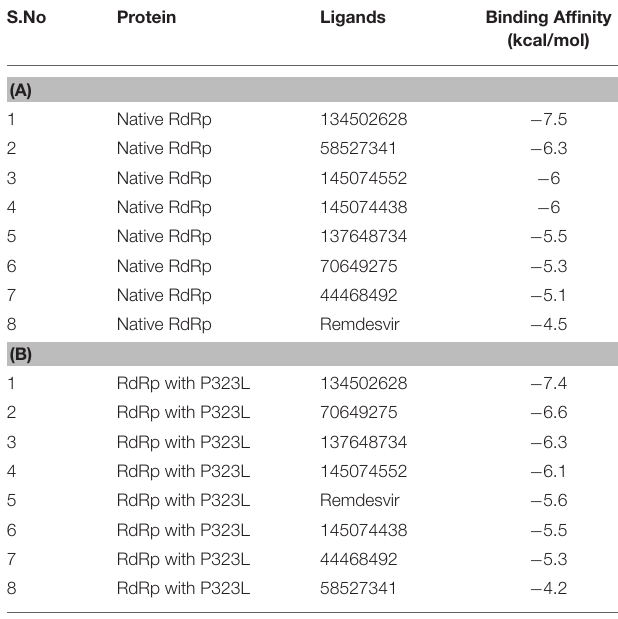
TABLE 2 | The binding affinity of the ligands against native and mutant SARS-CoV-2 RdRp